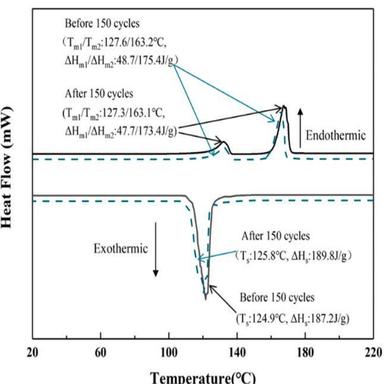
CPCM3 DSC curves before and after 150 cycles.